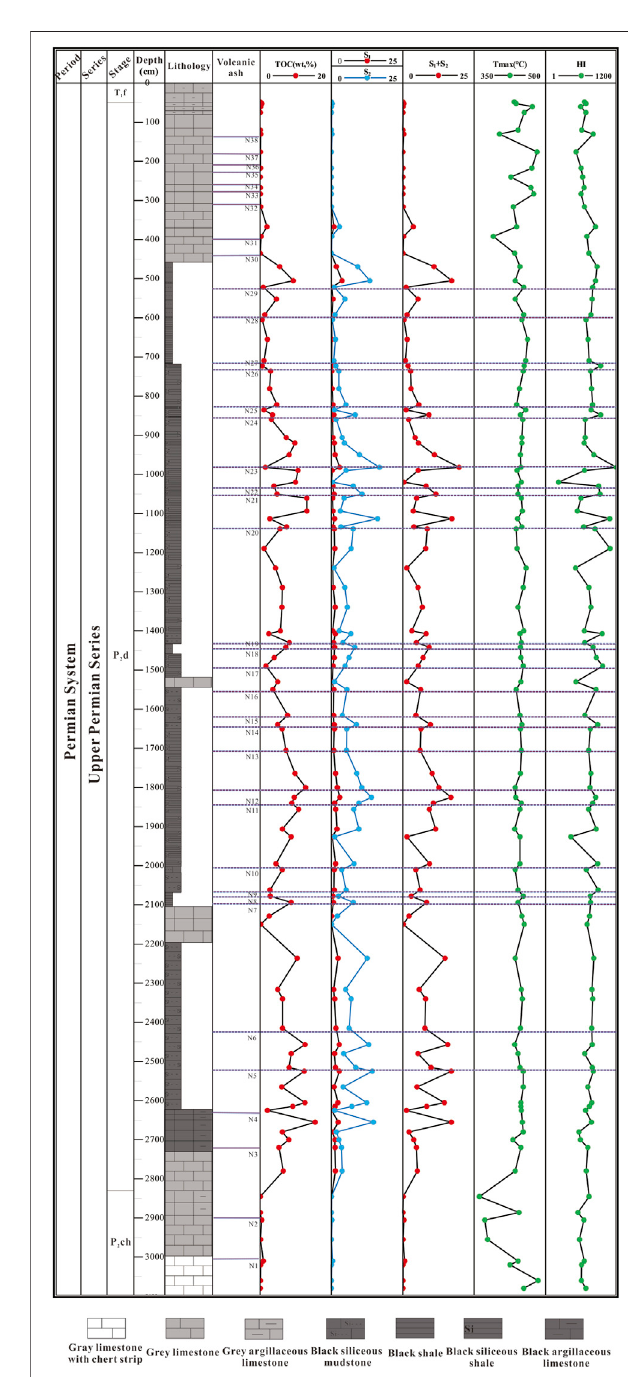
FIGURE 5 | Rock pyrolysis data of Longfeng quarry pro fi le